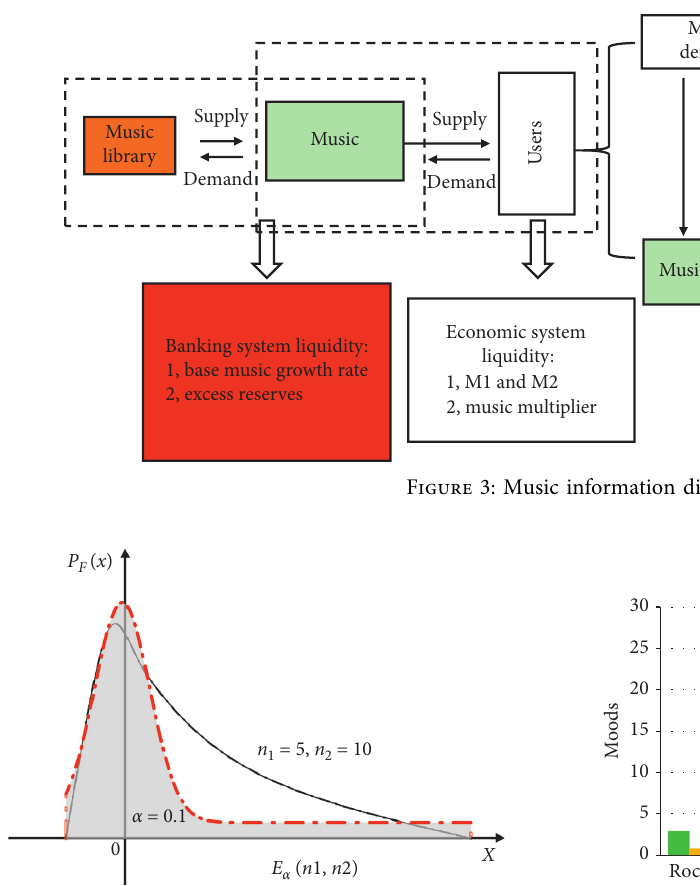
Figure 4: Corresponding popularity ( P